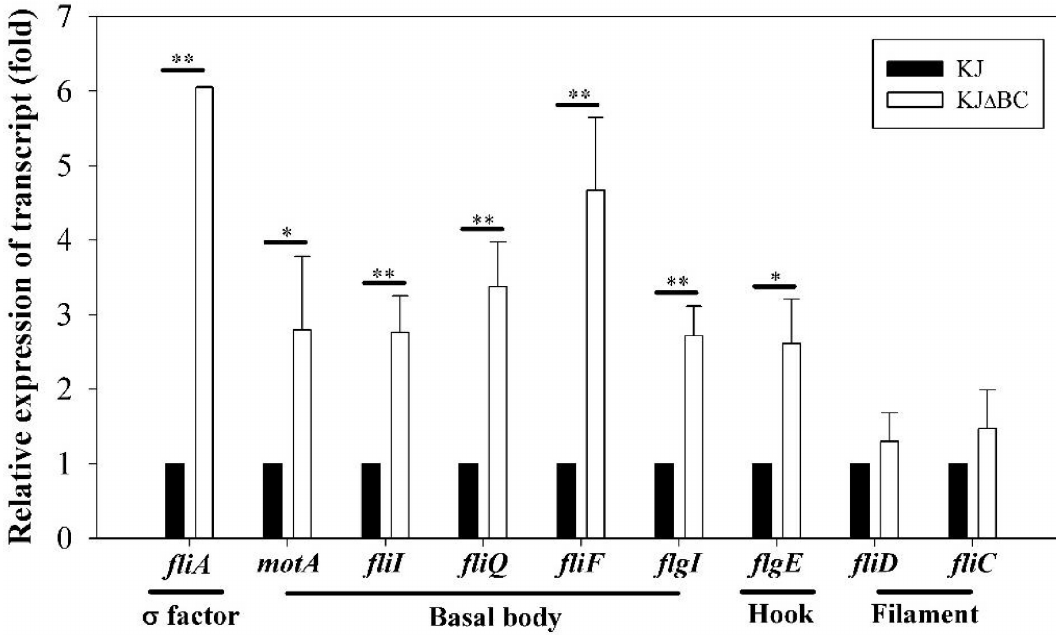
Fig 5. The transcript changes (folds) of selected flagella-related genes between KJ and KJ Δ BCcells by qRT-PCR. Total mRNA was extracted from KJ and KJ Δ BC logarithmic-phase cultures. cDNA was preparedby RT-PCR and used as the template for qRT-PCR. The expressionof target gene transcripts in qRT-PCR were normalized to the level of expression of the 16S rRNA gene by using the ΔΔ C T method. Data are the means from three independentexperiments. Error bars represent the standarddeviations for three triplicate samples. * , p < 0.05; ** , p <